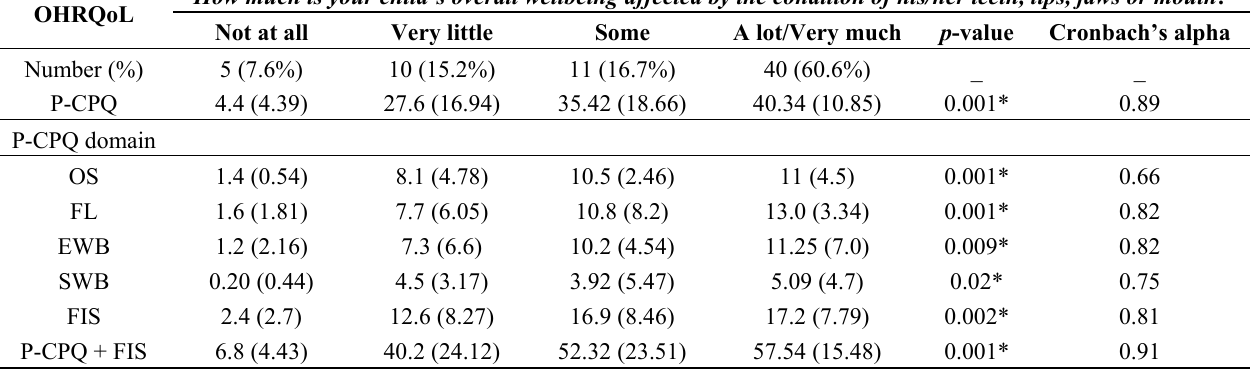
Table 2. Pretreatment Parental-Caregivers Perceptions Questionnaire (P-CPQ) scale (and subscale) and Family Impact Scale (FIS) and Cronbach’s